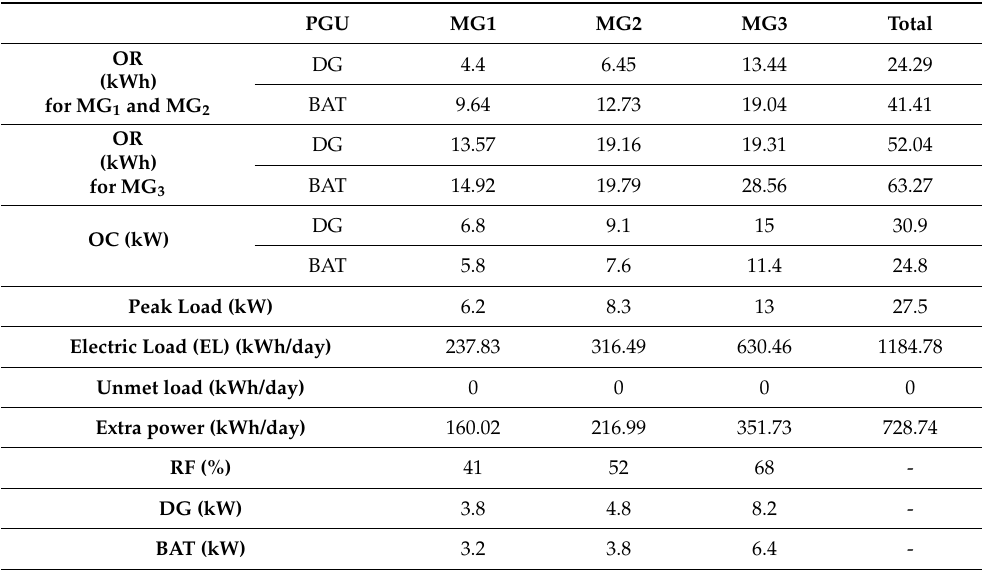
Figure 5. Optimal operation of the HIMGs: ( a ) MG 1 , ( b ) MG 2 , and ( c ) MG 3. Table 5. HIMG